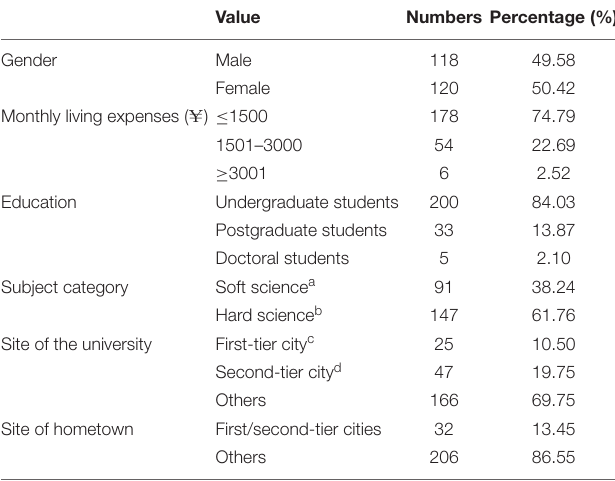
TABLE 1 | Sample profile ( N =